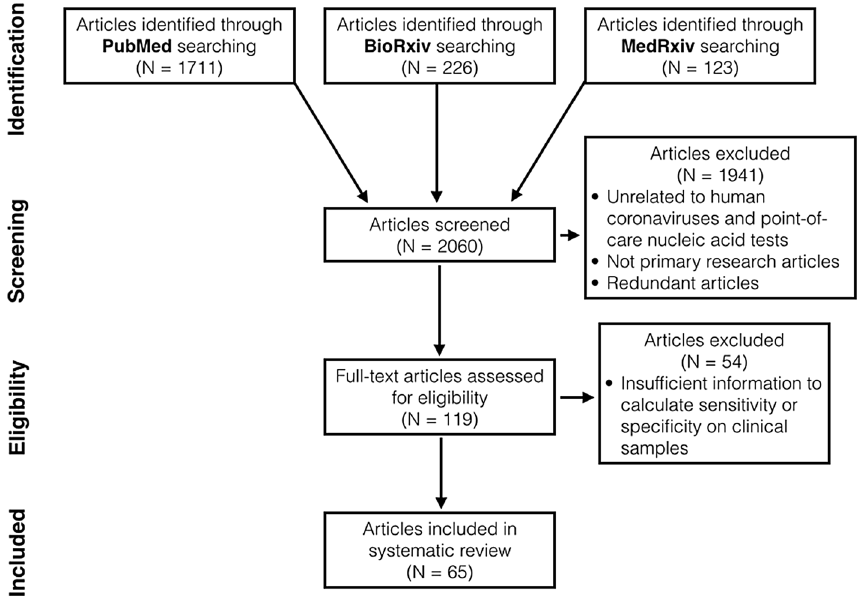
Figure 1. The preferred reporting items for a systematic review and meta-analysis (PRISMA) flow